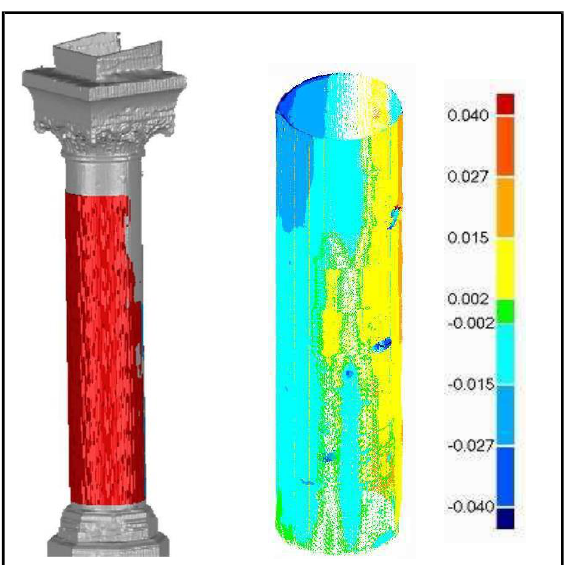
Figure 13. Displacements map, surveyed model (grey) extruded model (red).